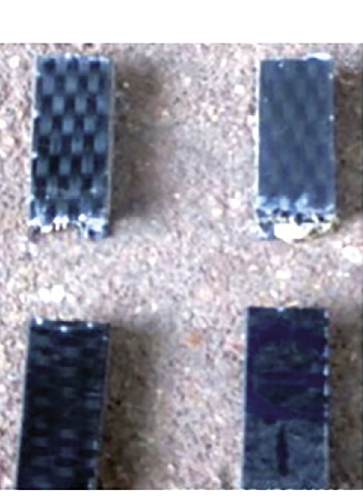
Figure 2: (a) Banana fiber; (b) carbon fiber and (c) composite laminate.